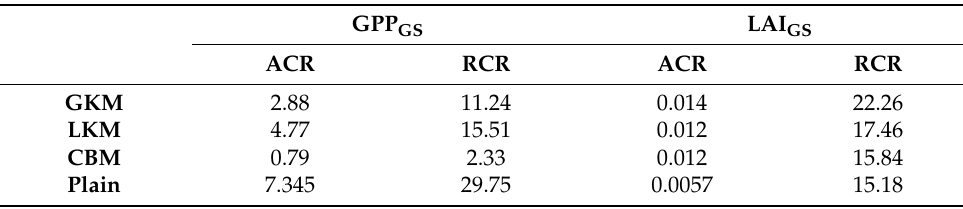
Table 2. The absolute change ratio (ACR) and relative change ratio (RCR) of GPP GS and mean value of LAI within the growing season (LAI GS ) from 1982 to 2015 across the